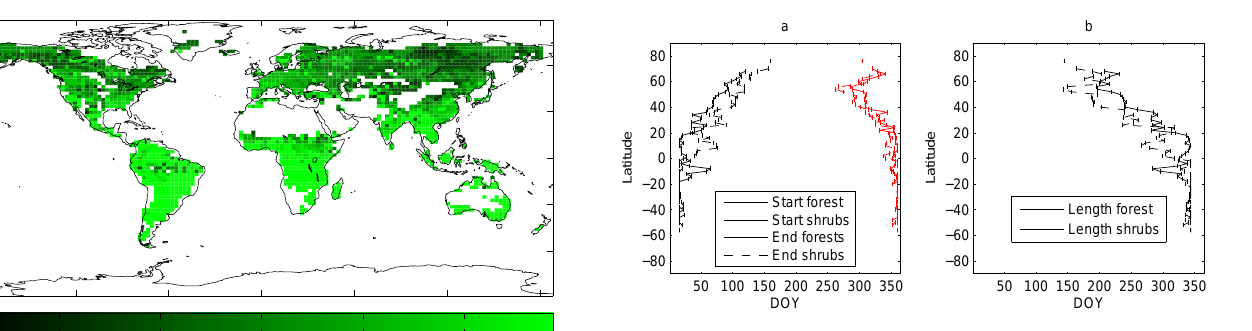
Fig. 11. Variation in growing season (a) start date and end date and (b) length with latitude for forests and